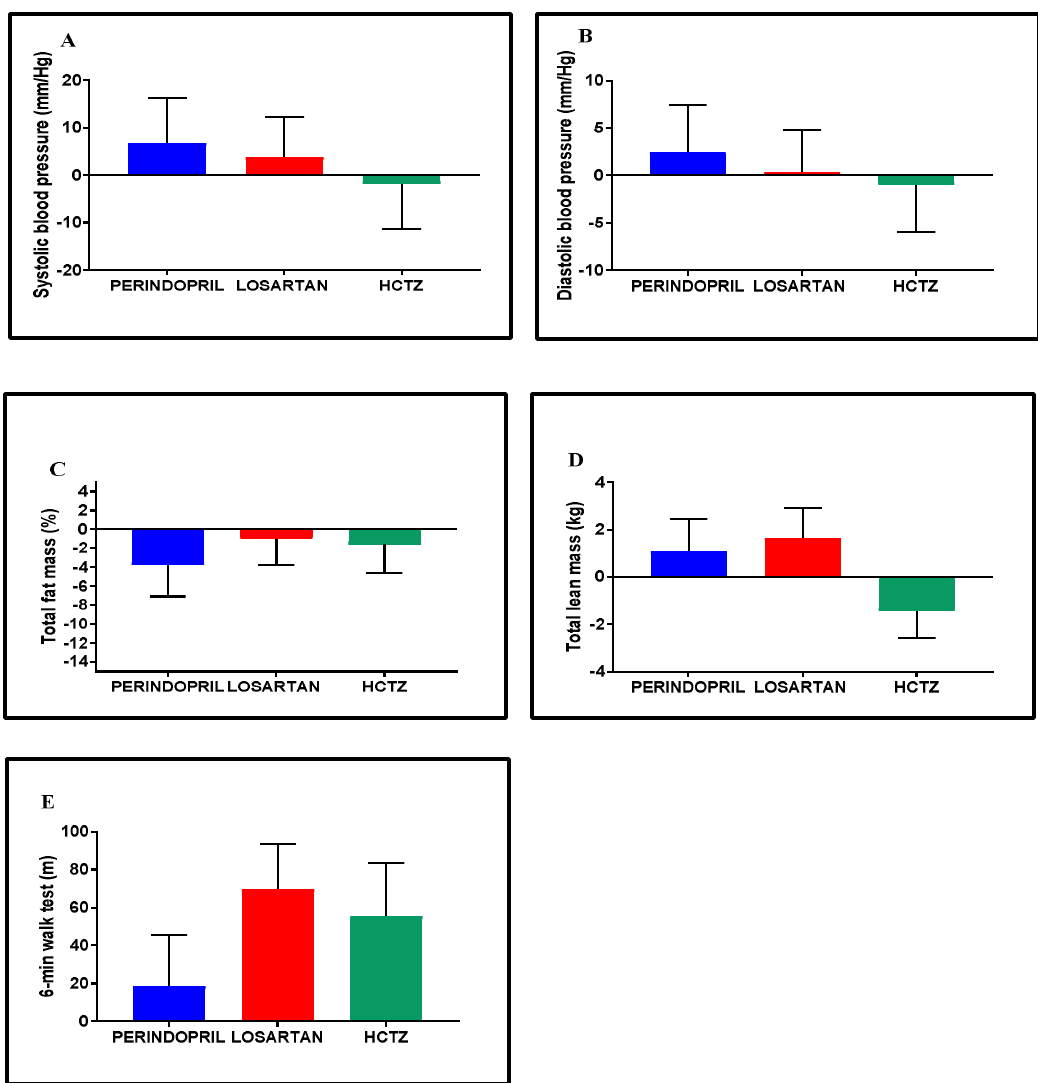
Figure 4. Adjusted mean change within groups in blood pressure ( A , B ), body composition ( C , D ), and exercise capacity ( E ) from baseline to 24-week follow-up. Data are expressed as adjusted mean change within groups with 95% confidence intervals adjusted to age, sex, and baseline status.